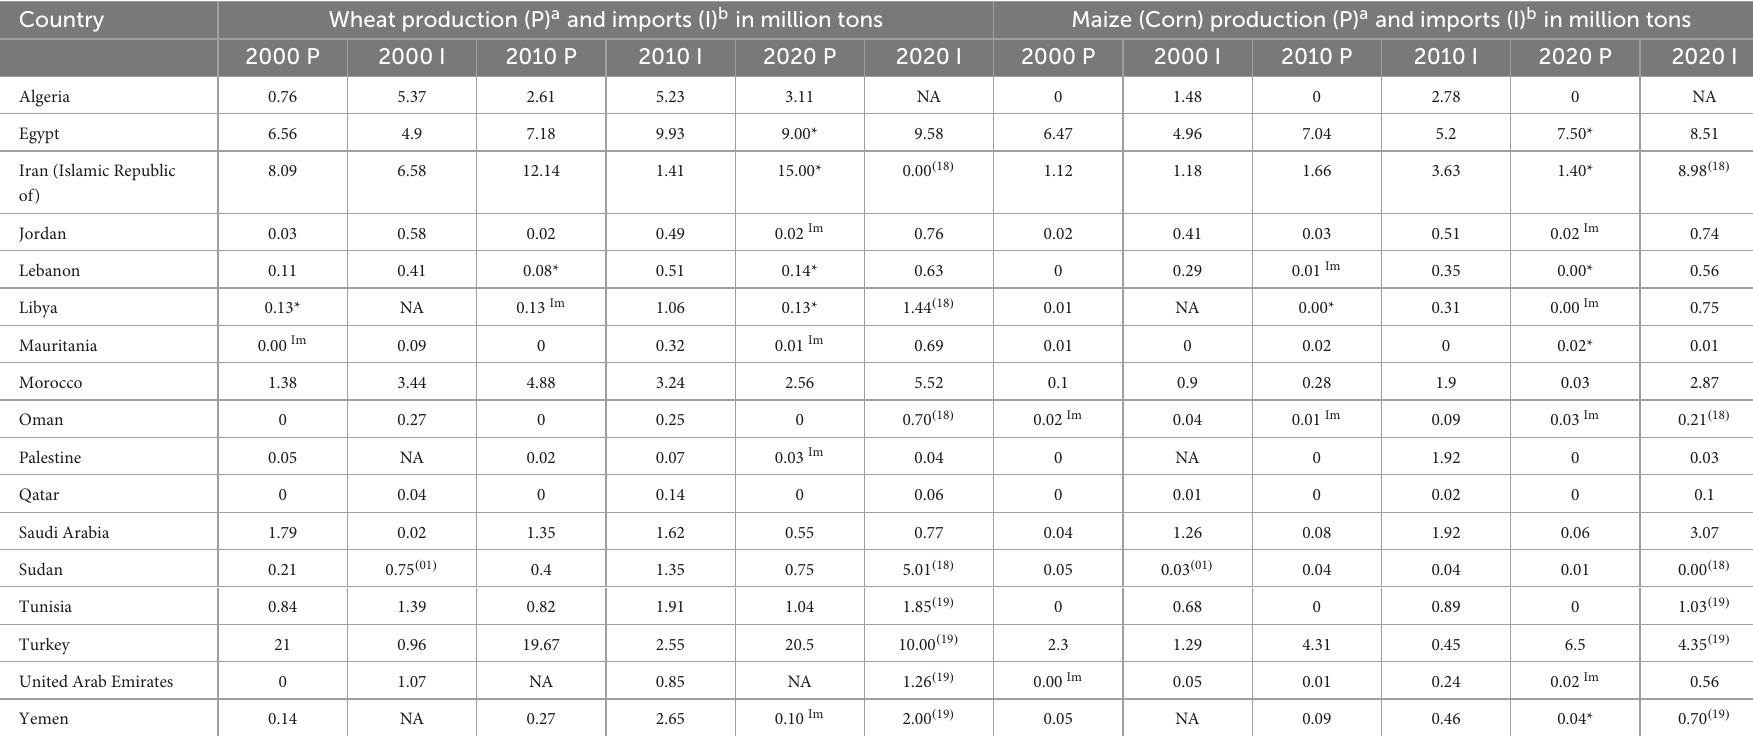
TABLE 5 Wheat and corn production and imports in selected Middle East countries.